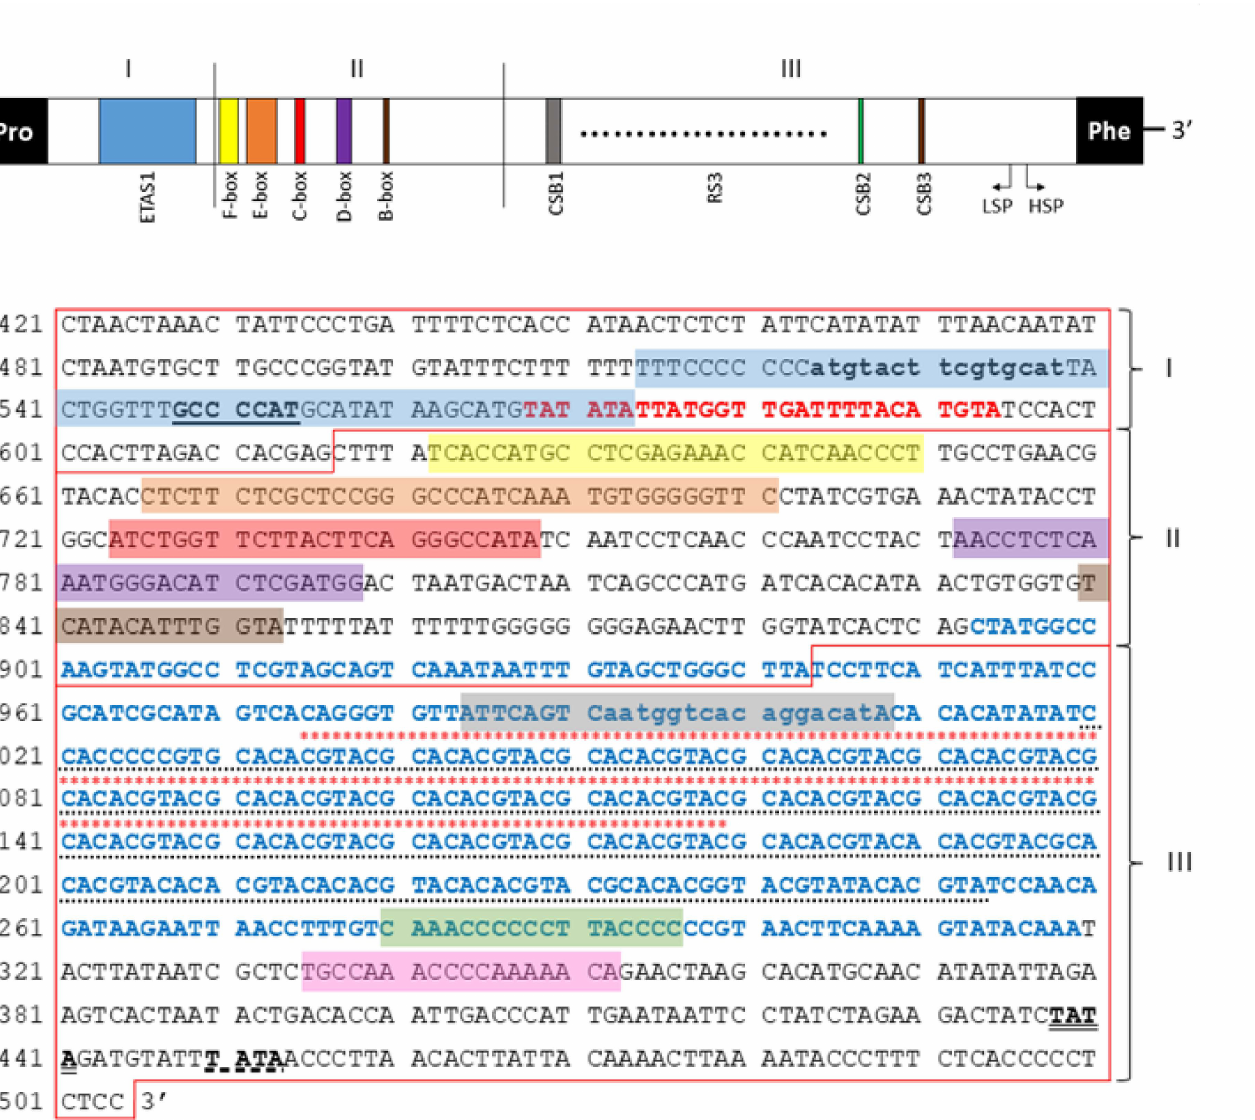
Figure 7. Schematic diagram of the organization ( A ) and nucleotide sequence ( B ) of the mtDNA control region of European mink (I—ETAS domain, II—CD domain, III—CSB domain; ETAS1 se- quence indicated by a blue box; ATGN 9 CAT motif in bold lowercase; D-loop termination underlined; TAS-A sequence in bold red; F, E, D, C and B box sequence indicated by a yellow, orange, red, purple and brown box respectively; CSB1, CSB2 and CSB3 block sequence indicated by a grey, green and pink box respectively; RS3 region underlined by dots; CpG island region in bold blue; inverted repetitive sequences rich region indicated by red upper asterisks; LSP sequence double